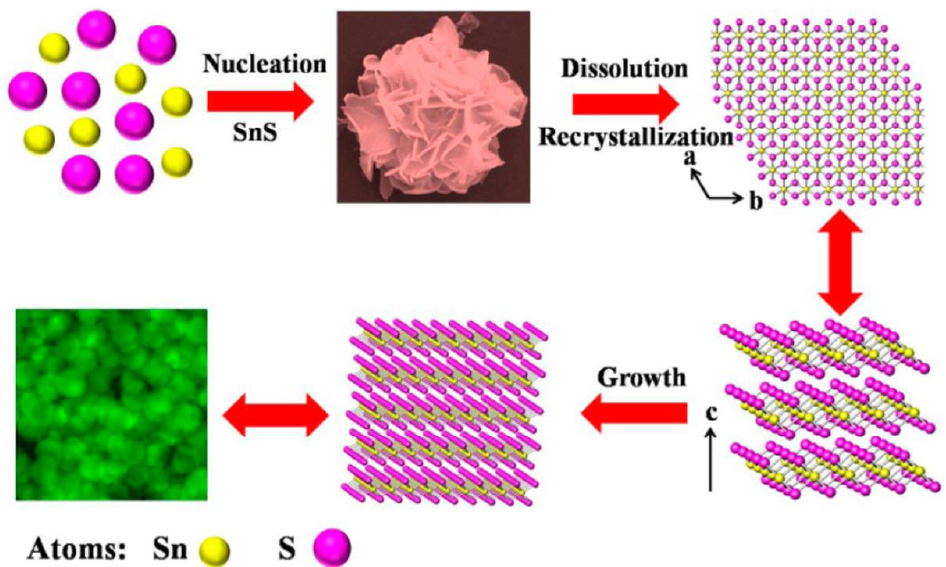
Figure 3. Formation mechanism of SnS 2 nanostructures during the solvothermal process. Reproduced with permission from [38].